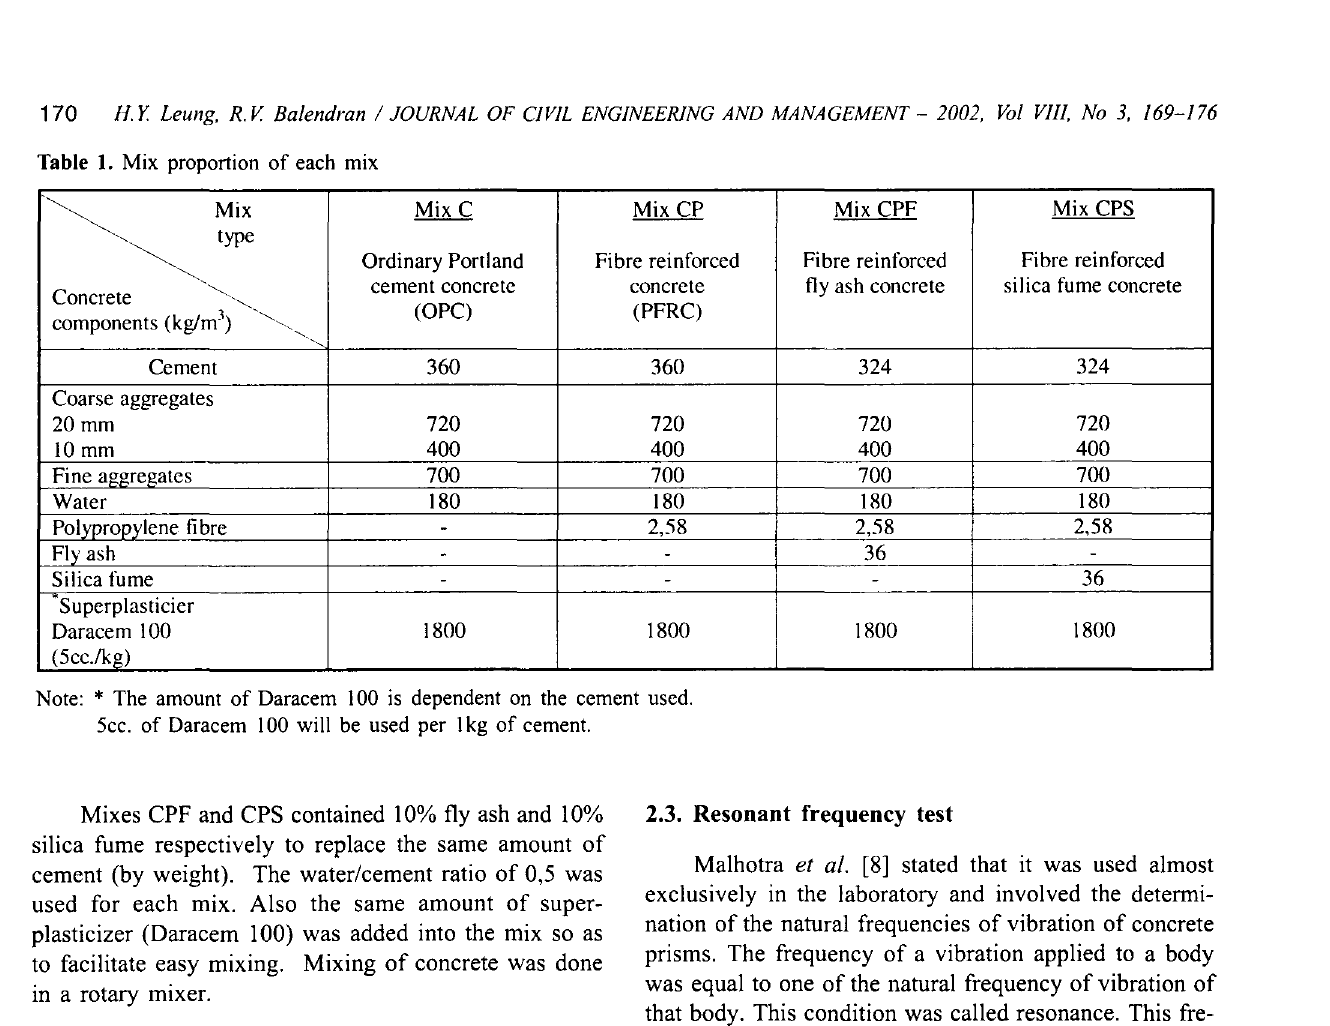
Table 2. Properties of polypropylene fibres [7] Specitic gravity